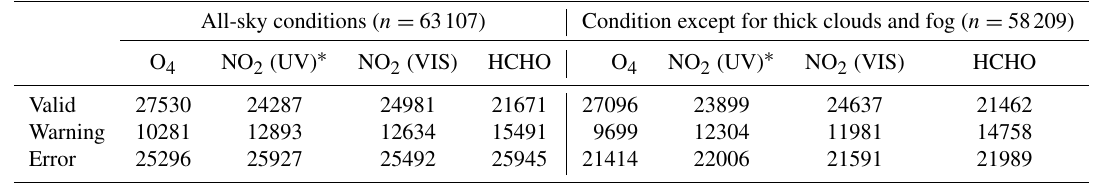
Table 2. Frequency of MAPA retrievals flagged as “valid”, “warning”, or “error” for various species and different sky conditions. All-sky conditions ( n = 63107) Condition except for thick clouds and fog ( n = 58209) O 4